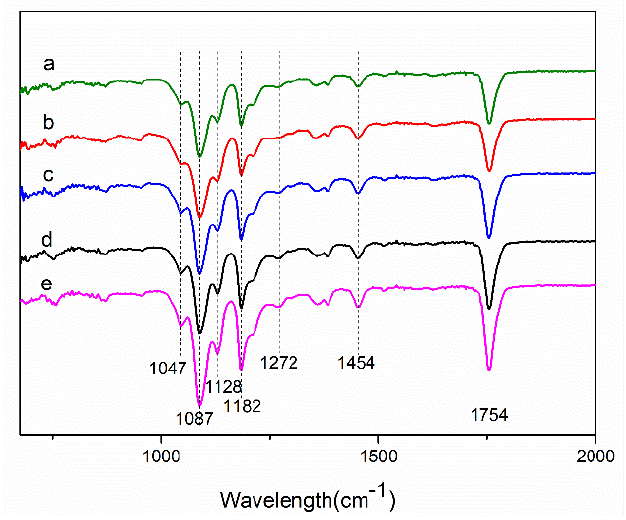
Figure 2. Fourier-transform infrared (FTIR) spectra of PLA/PEG/Cur CNFs with different weight ratios (PEG:PLA): ( a ) 1:1; ( b ) 1:3; ( c ) 1:5; ( d ) 1:7; ( e ) 1:9.